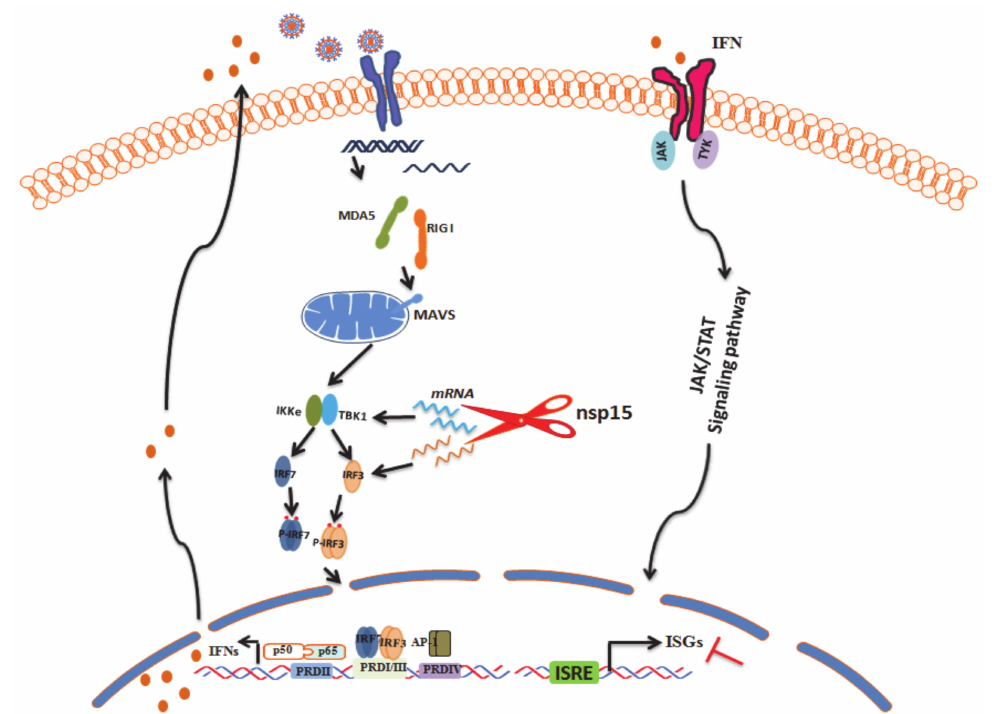
Figure 8. PEDV nsp15 antagonizes host antiviral response by degradating the RNA levels of TBK1 and IRF3. During PEDV infection, the RNA transcriptional levels of TBK1 and IRF3 were degraded by viral encoded nsp15 protein in an endoribonuclease activity dependent manner, resulting in reduction of endogenous TBK1 and IRF3. The decreased TBK1 and IRF3, two key e ff ectors during IFN signaling pathway, circumvent IFN production and IFN mediated antiviral